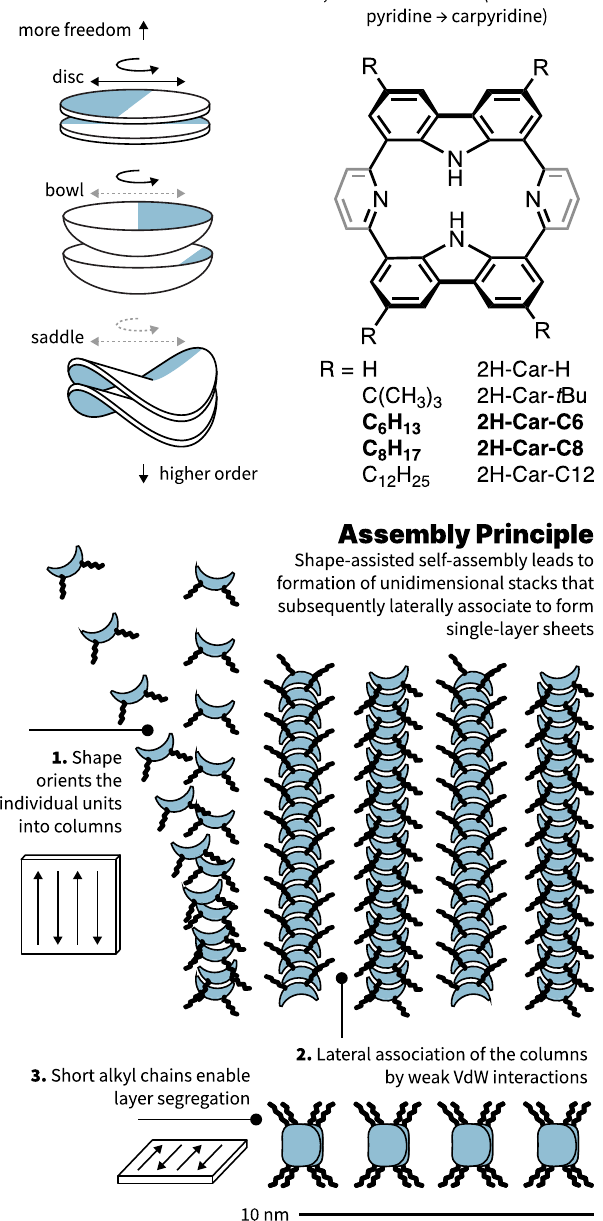
Fig. 1 Design principle, structural scheme, and assembly process. Left, Shape as a design principle to restrict rotational and translational freedom. Right, Generic chemical structure of carpyridines with R group modi fi cations to the core. Bottom, Multi-stage assembly process, where (i) units assemble into linear stacks guided by the shape of their core and driven by entropy before (ii) assembling into de fi ned